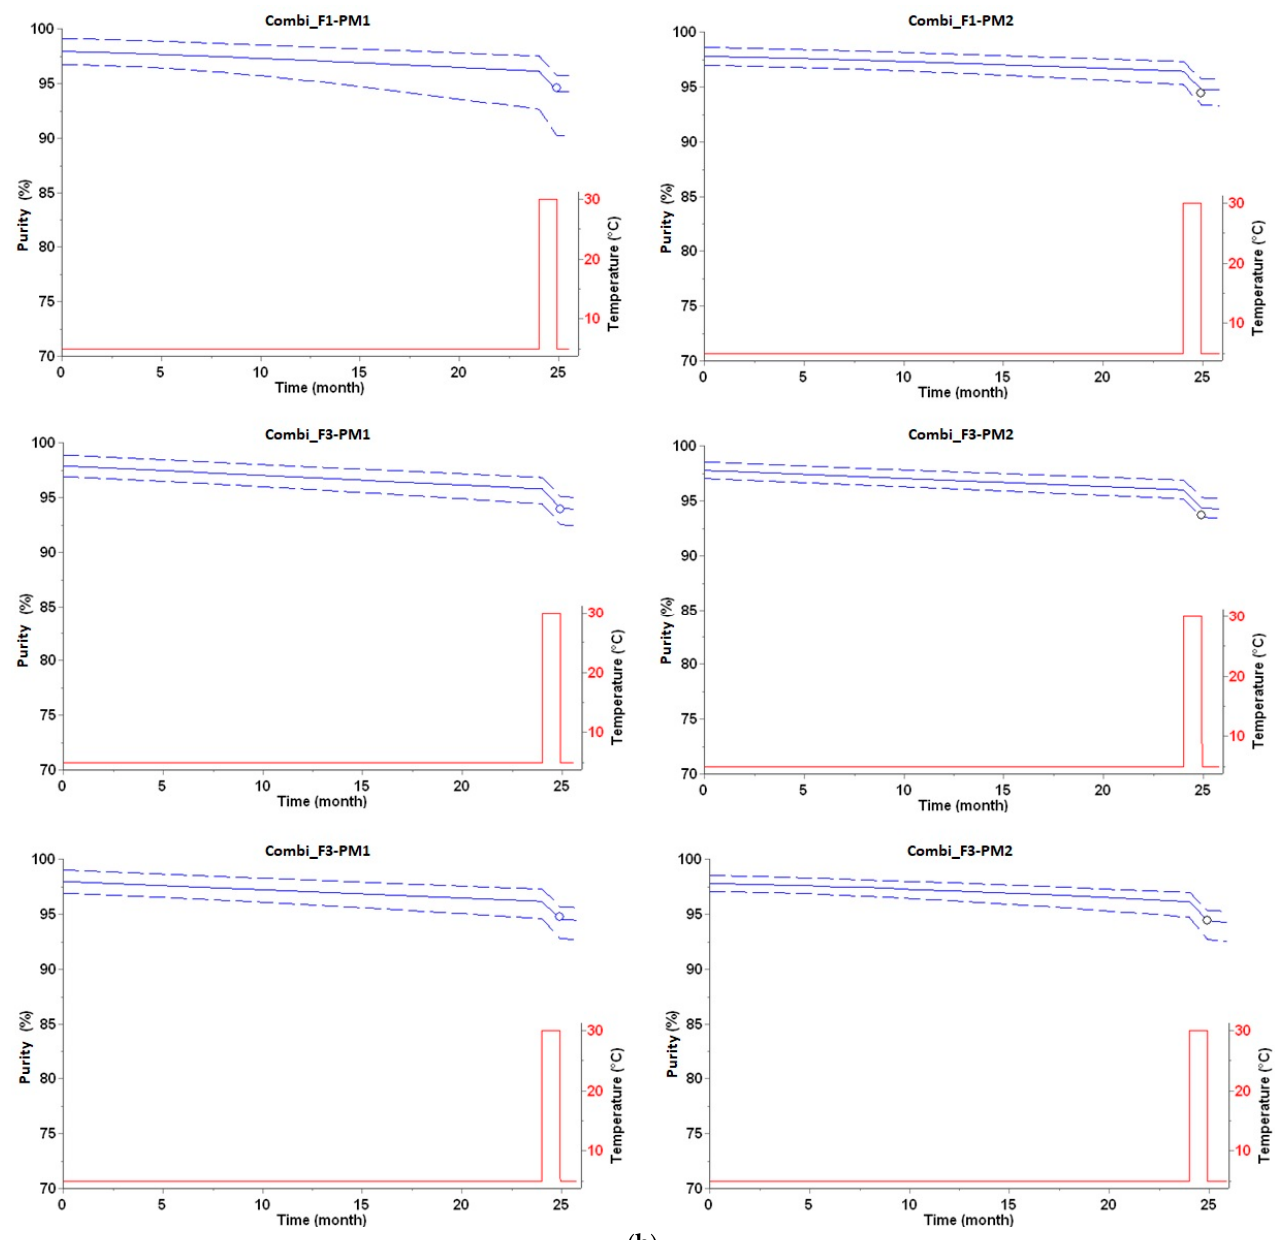
Figure 2. Predictions of peptide purity (in %) for three different formulations in two different packaging materials. ( a ) Purity predictions are displayed as lines for up to 2.5 years at 5 °C (blue), 25 °C (red), 30 °C (green), 37 °C (pink) and 40 °C (cyan). High-Performance Liquid Chromatography (HPLC) data used for kinetic modeling are displayed as filled circles. Experimental long-term stability data points, that were not used for model building, are displayed as open circles. Data after 9 months were only determined for PM1 due to capacity limitations of the analytical lab. At 5 °C, purity predictions are shown with predictive bands representing 99.9% PI (dashed lines). Additional experimental data obtained after two years, not used for kinetic modeling, are displayed as open circles. ( b ) Purity of peptides predicted from best kinetic models (blue solid lines) during temperature excursions (28 days at 30 °C) outside the cold chain (two years). Purity predictions are shown with predictive bands representing 99.9% PI (dashed lines). Experimental data determined at the end of temperature excursions, and not used for kinetic modeling, are displayed as open blue circles.